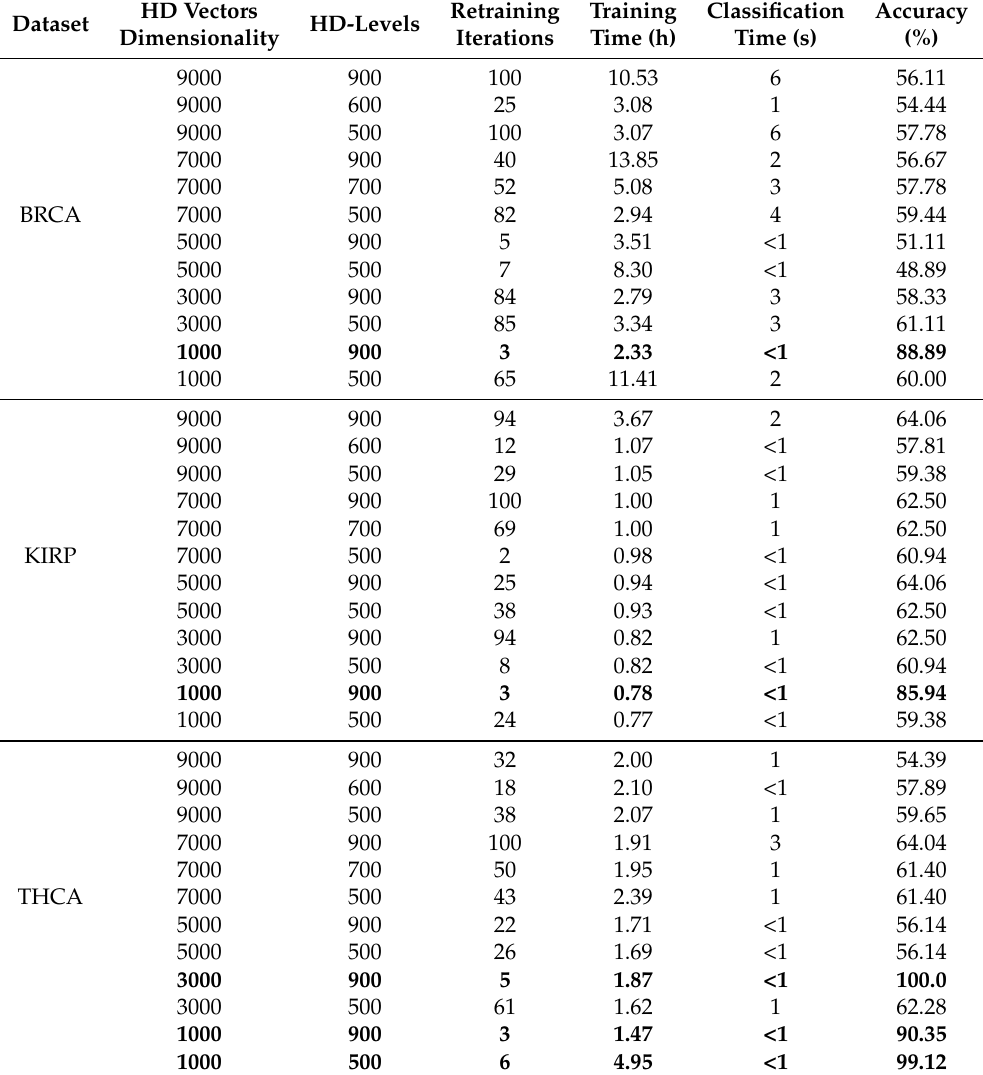
Table 4. Benchmarks of the HD classification algorithm performances with different configurations of HD vectors dimensionality and HD-levels with a maximum amount of 100 retraining iterations. The best result achieved by the HD-classifier after the number of retraining iterations is shown. The configurations that led to a classification accuracy greater than 80% have been